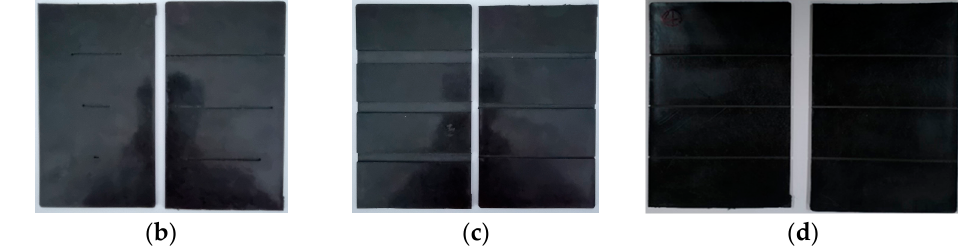
Table 3. Details of thermographic raw data to be processed by HA.